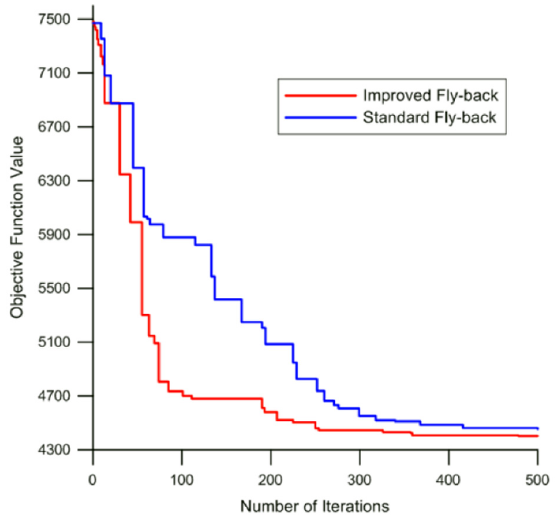
Fig. 17. Comparison between the standard and improved fly- back mechanism on 18-bar truss